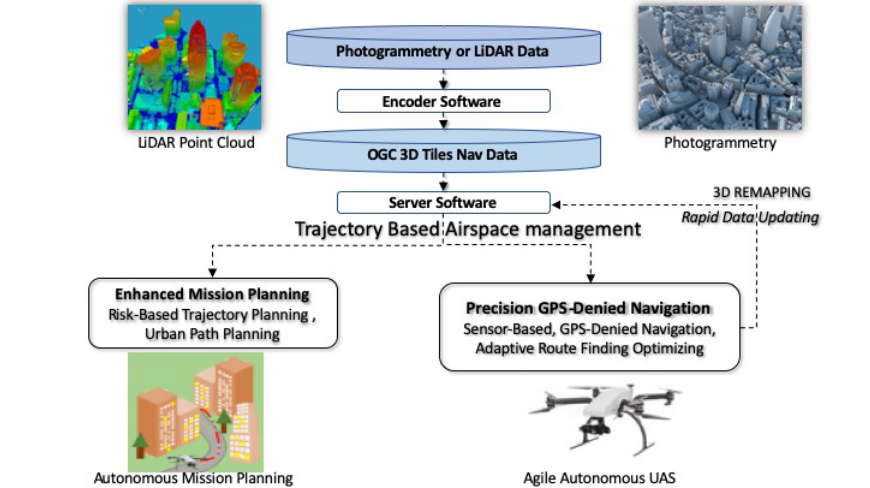
Figure 1. Overall operational overview for low altitude urban